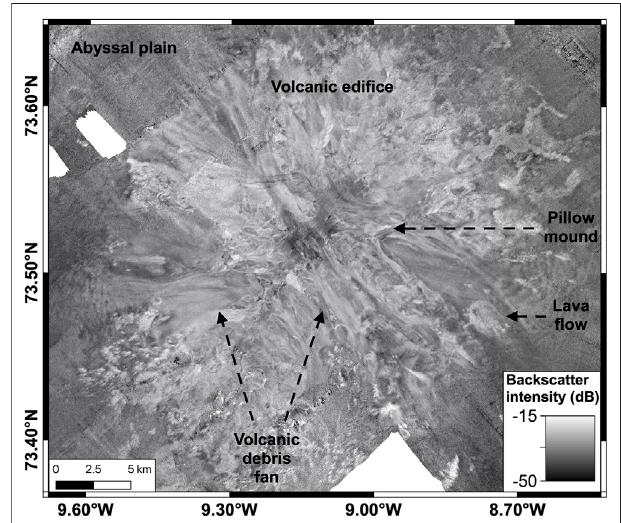
FIGURE 6 | Map of the acquired backscatter data, highlighting lava fl ows and volcaniclastic deposits.